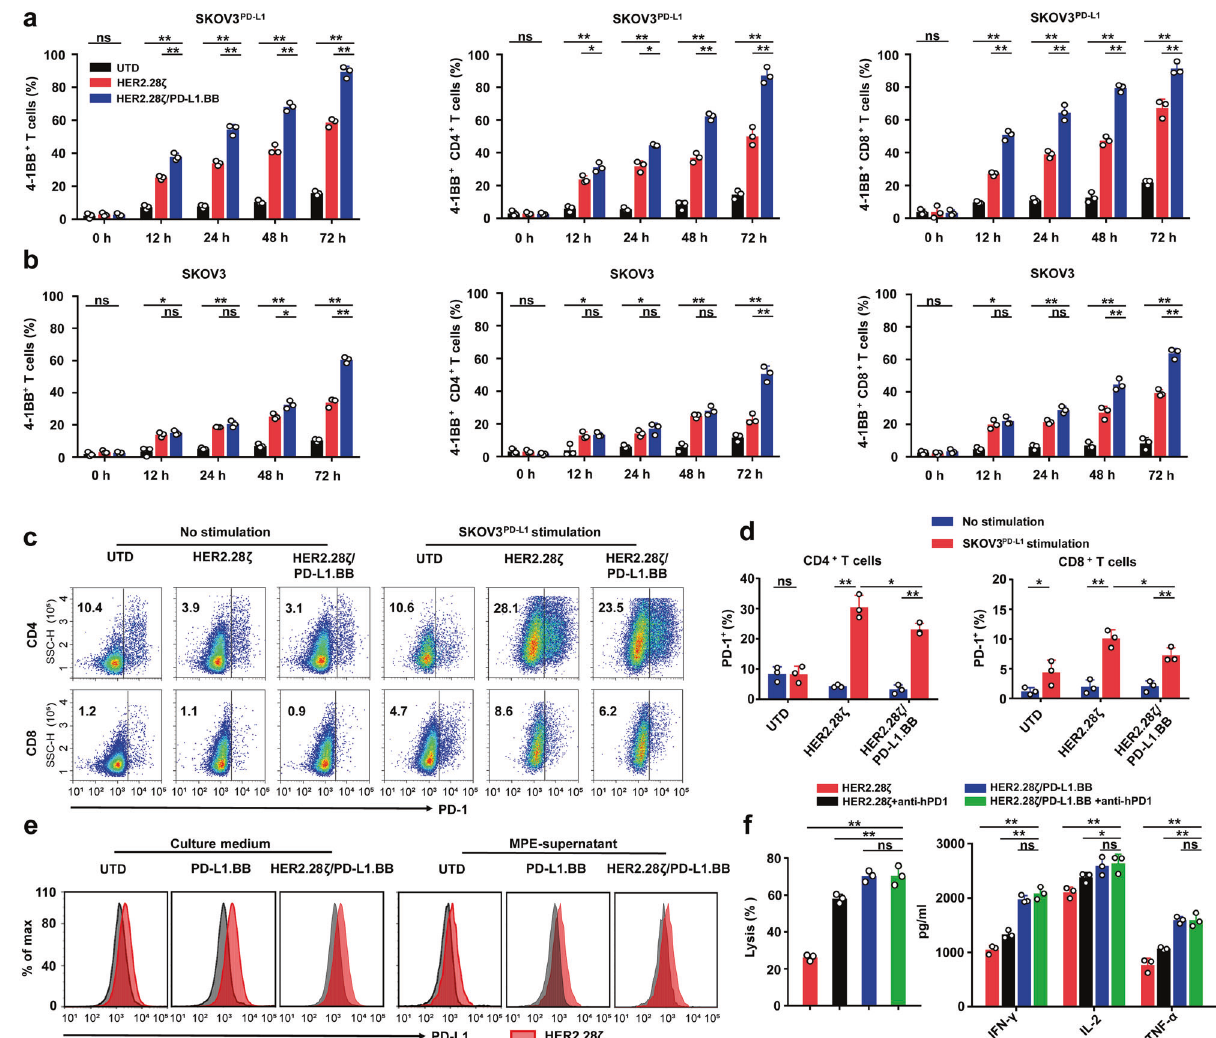
Fig. 4 PD-L1.BB CSR engagement enhances 4-1BB expression and inhibits PD-1/PD-L1signals. a , b Statistical analysis of 4-1BB expression on HER2.28 ζ and HER2.28 ζ /PD-L1.BB CAR-T cells after stimulation. CAR-T cells were stimulated by either a irradiated SKOV3 PD-L1 or b SKOV3 cells (E: T = 2: 1) in culture medium, and 4-1BB expression was assessed by fl ow cytometry at the indicated time points. c Representative fl ow cytometry plots showed PD-1 expression on CD4 + and CD8 + CAR-T cells on day 5 after stimulation (E: T = 2: 1). d Statistical analysis of PD-1 expression on CD4 + and CD8 + CAR-T cells. e PD-L1 expression on CAR-T cells. CAR-T cells were incubated with irradiated SKOV3 PD-L1 cells (E: T = 2: 1) for 5 days, either in culture medium or MPE-supernatant (Pt1, as Supplementary Table. S1). f The cytotoxicity and cytokine release of HER2.28 ζ and HER2.28 ζ /PD-L1BB CAR-T cells before and after PD-1 blockade. CAR-T cells were stimulated with irradiated SKOV3 PD-L1 cells, and treated with PD-1 blocking antibody (Tislelizumab, 10 μ g/ml) for 3 days. Then the post-stimulated CAR-T cells were co-incubated with SKOV3 PD-L1 (E: T = 2: 1) for 24 h. The cytotoxic activity of CAR-T cells was analyzed by CCK-8, and effector cytokine (IFN- γ , IL-2 and TNF- α ) in culture supernatant were measured by ELISA. P -values were determined by one-way ANOVA with Tukey ’ s multiple comparison test adjusted P value ( a , b , f ) or unpaired two-tailed t-test d . * P <0.05; ** P <0.01, ns, not signi fi cant. Data show the mean ± SD from three independent experiments PD-L1.BB CSR engagement upregulates T-cell activation, HER2.28 ζ /PD-L1.BB CAR-T cell-treated mice (Fig. 5m), which has cytotoxicity, and proliferation-related gene expressions also been reported by others that the cytokine secretion of CAR-T cells was enhanced after PD-1/PD-L1 blockade. 34 For long-term in vivo persistence, peritoneal lavage fl uid was collected 2 weeks after tumor regression (day 34). Although CAR-T cells were hardly detected in most mice, a signi fi cantly higher CAR copy number was detected in HER2.28 ζ /PD-L1.BB CAR-T cell-treated mice (Fig. 5n). sion pattern compared to HER2.28 ζ CAR-T cells at 12 h, 24 h, and Overall, these data demonstrated that PD-L1.BB CSR engage- ment signi fi cantly enhanced the in vivo cytotoxicity, proliferation, and persistence of HER2.28 ζ CAR-T cells, which fi nally leads to regulated genes and 142 down-regulated genes (Fig. 6a). We rapid and durable eradication of pleural and peritoneal further identi fi ed 182 DEGs with more signi fi cant differences using metastasis. stricter criteria (FC ≥ 2, Q ≤ 0.001), including 90 up-regulated genes